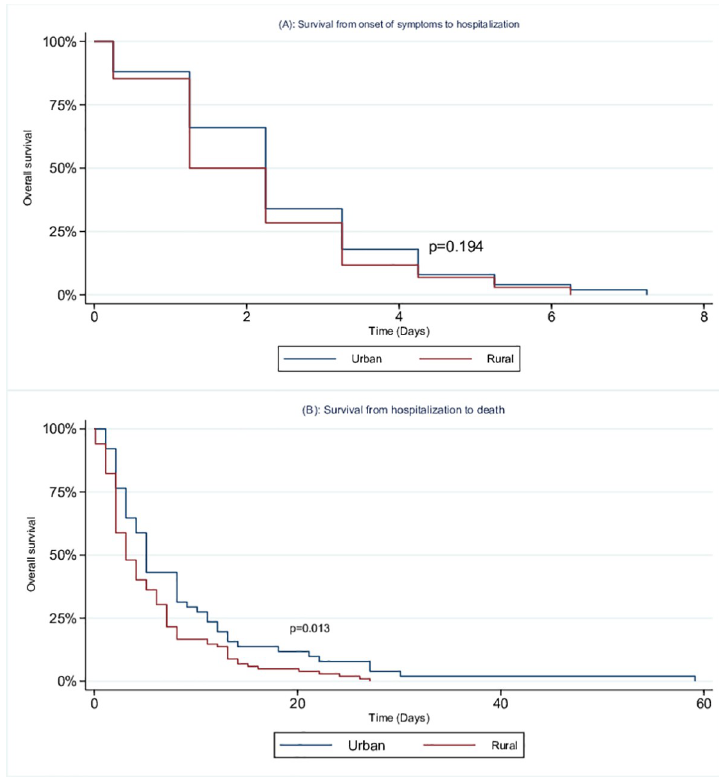
Fig 2. Kaplan-Meier survival estimates among children aged < 5 years who died with SARI in urban and rural sites, South Africa, 2009 to 2013. (A) Survival from onset of symptoms to hospitalization (B) Survival from hospitalization to